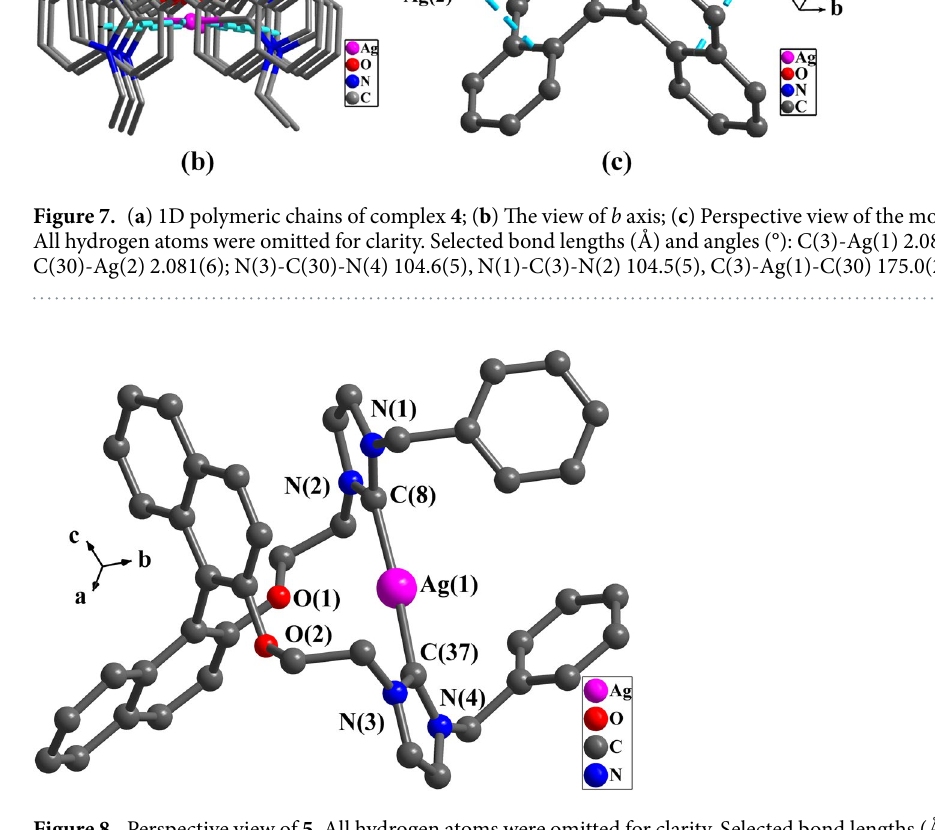
Figure 8. Perspective view of 5 . All hydrogen atoms were omitted for clarity. Selected bond lengths (Å) and angles (°): Ag(1)-C(8) 2.086(4), Ag(1)-C(37) 2.090(4); C(8)-Ag(1)-C(37) 173.4(1), N(2)-C(8)-N(1) 104.5(4), N(3)-C(37)-N(4) 104.5(3). All hydrogen atoms were omitted for